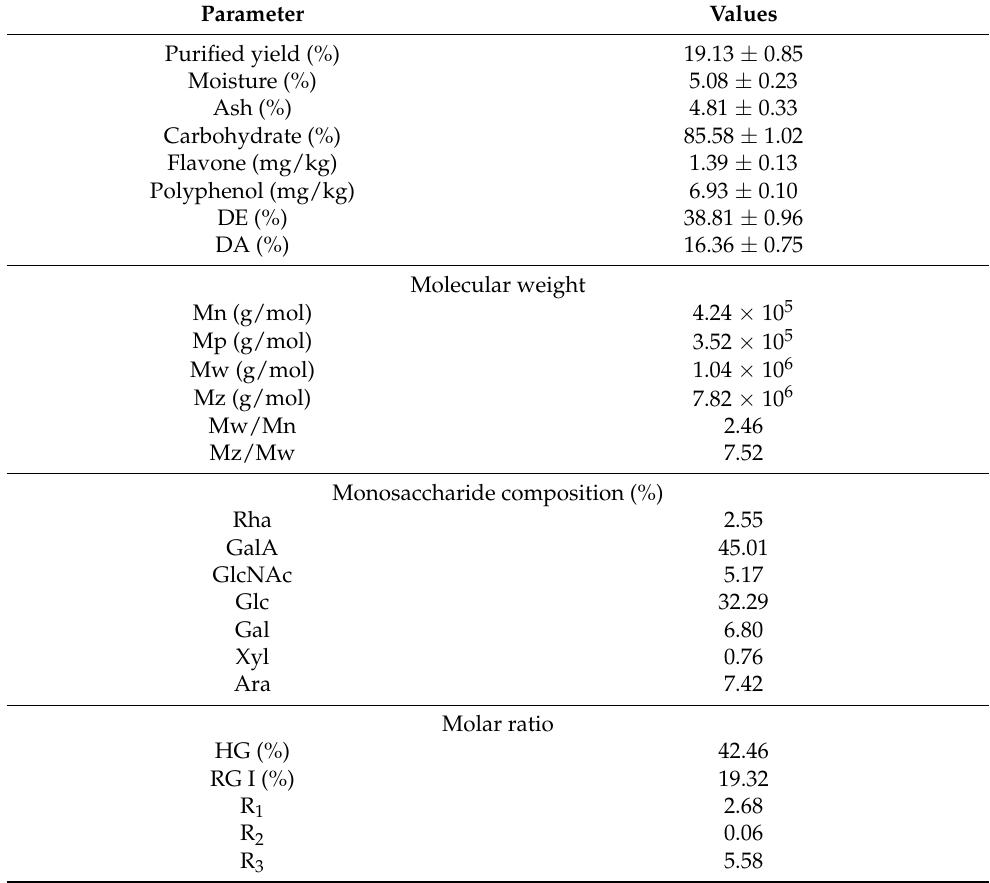
Table 1. Physicochemical characterization of